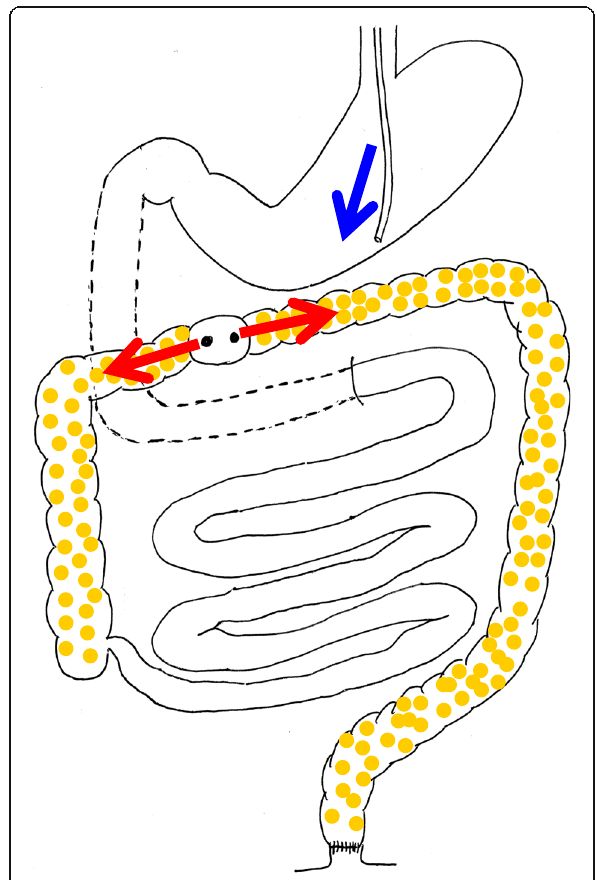
Fig. 7 Administration through the nasogastric tube (blue arrow) and the transverse colostomy (red arrows) of vancomycin was performed. Vancomycin was administered to the oral and anal side from the stoma